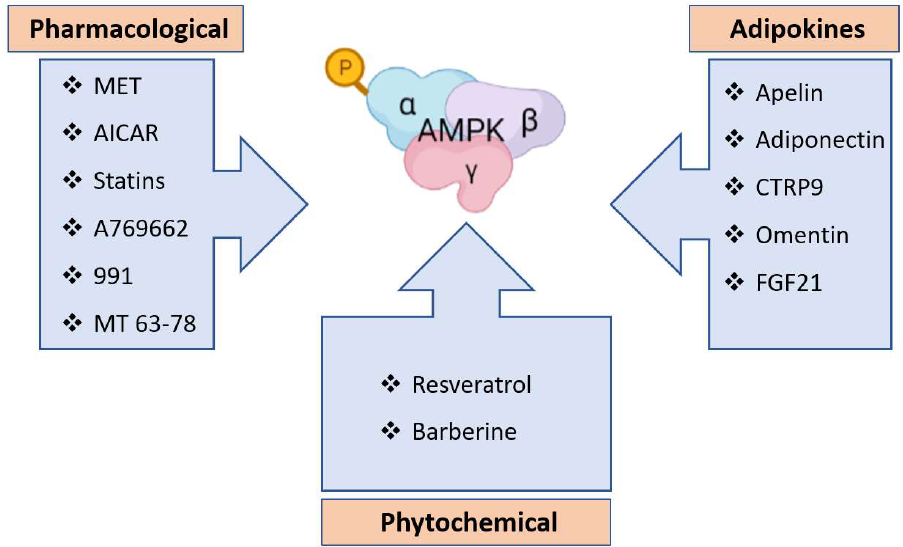
Figure 4. Summary of candidates for HPH treatment through AMPK activation.